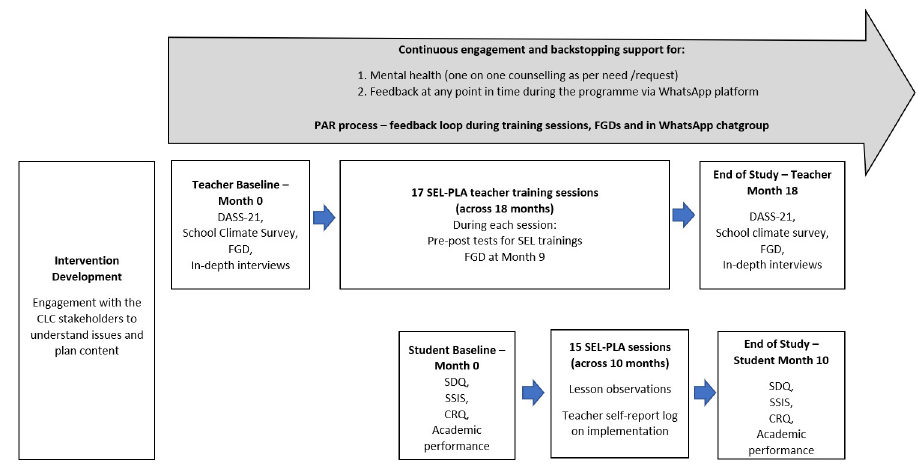
Fig 4. Project flow and assessment schedule for research data